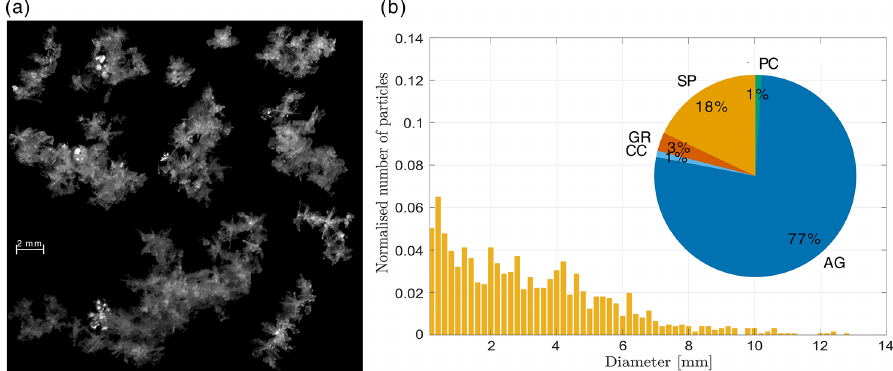
Figure 12. Same as Fig. 8 for the period 06:00 to 08:00UTC. The number of particles is 589. The average temperature is 0.1 ◦ C (Fig. 5e).